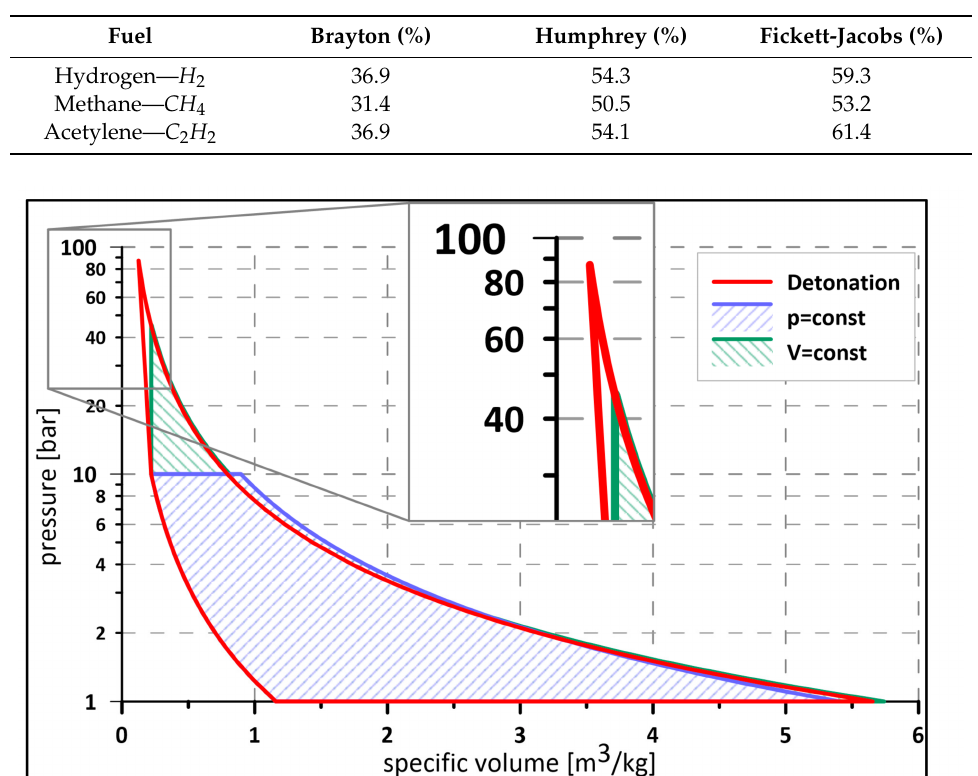
Table 1. Comparison of calculated efficiency for thermodynamic cycles: Brayton, Humphrey, and Fickett–Jacobs [10].